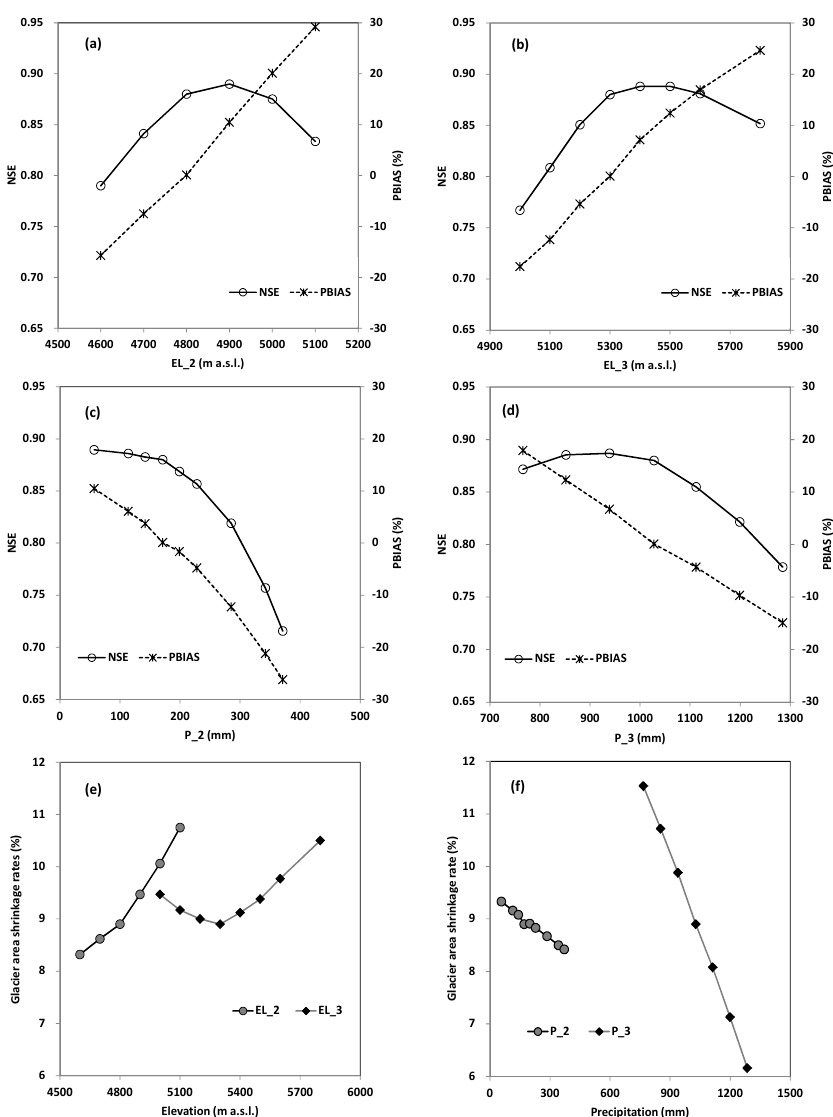
Figure 5. Plots of precipitation and elevation sensitivities at the second and third points using the variable PLAPS to simulate streamflow at KQHS and glacier area change in the Yarkant River basin. EL_2 and EL_3 represent the elevations of the second and third points, respectively; P_2 and P_3 represent the precipitation values of the second and third points, respectively. ( a – d ) the NSE and PBIAS values for scenarios in which EL_2, EL_3, P_2 and P_3 varied; ( e , f ) the glacier area shrinkage rates when one of EL_2, EL_3, P_2 or P_3 varied.